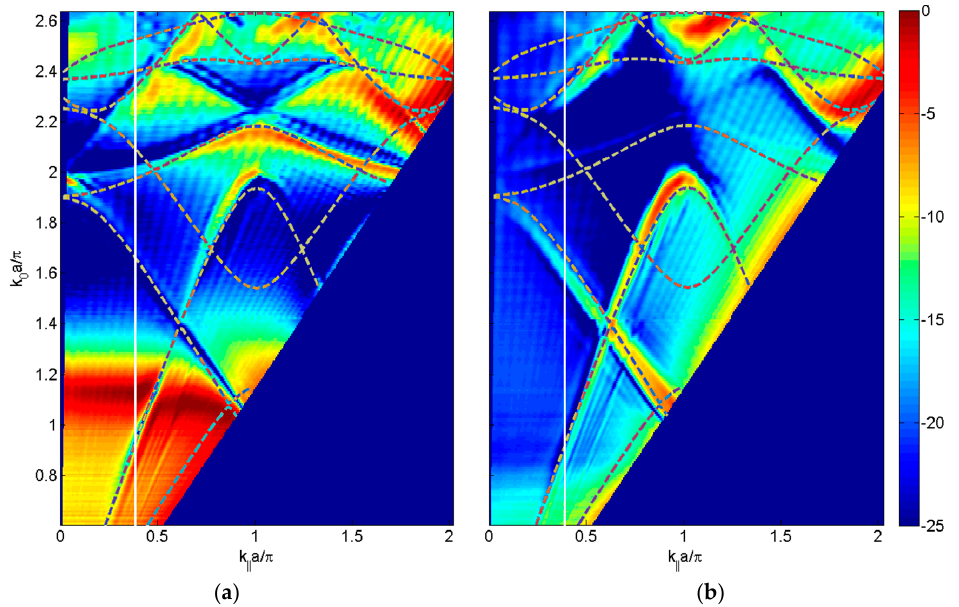
Figure 7. Dispersion diagram superimposed to measured transmitted sound power coefficient, τ , as a function of the parallel wavevector k ‖ · a / π in the Γ X direction and the normalized frequency k 0 · a / π , for the square distribution of circular holes having diameter, d , of 1 mm and a unit cell period, a , of 3 mm and the holes filled with ( a ) water and ( b ) air.